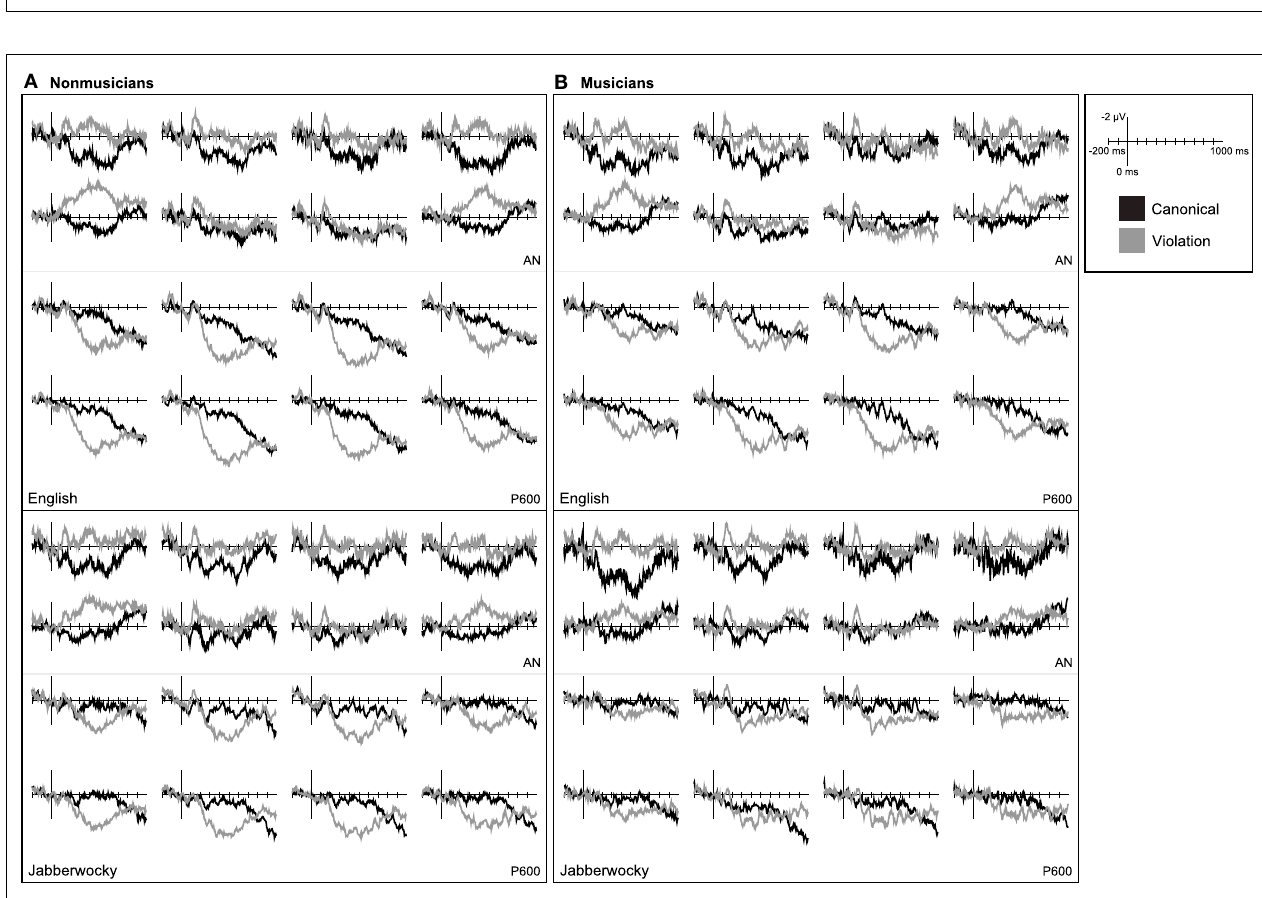
FIGURE 4 | Language ERPs. Grand average ERP waveforms elicited by critical words in canonical and violation contexts measured in (A) non-musicians and (B) musicians. Data for English sentences are shown on the top and for Jabberwocky sentences on the bottom.